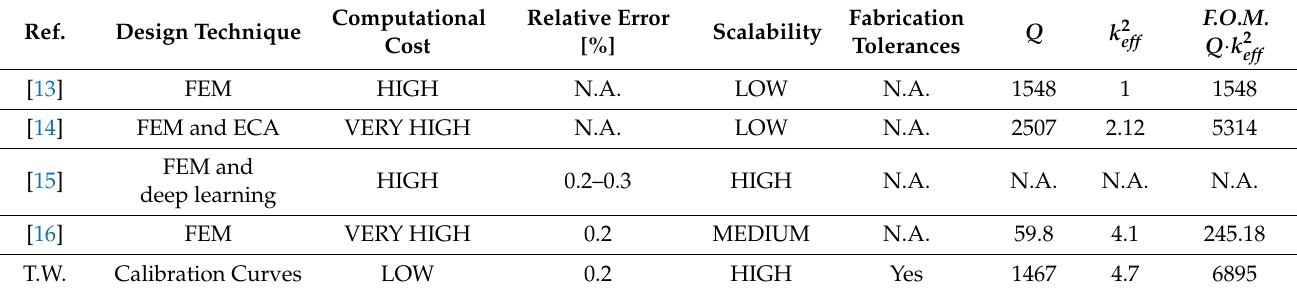
Table 2. Comparison between this work (T.W.) and the state of the art.